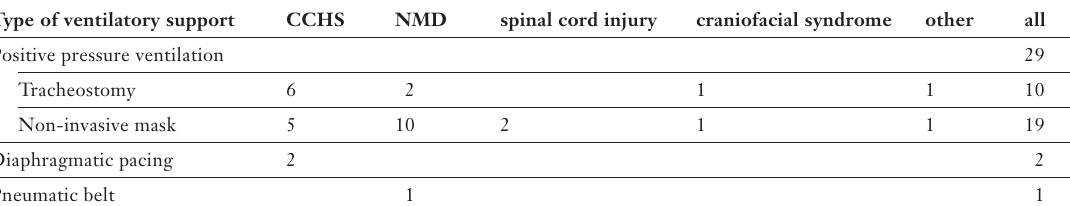
Number of children supported by long- term ventilation according to type of ventilatory support and underlying aetiology.